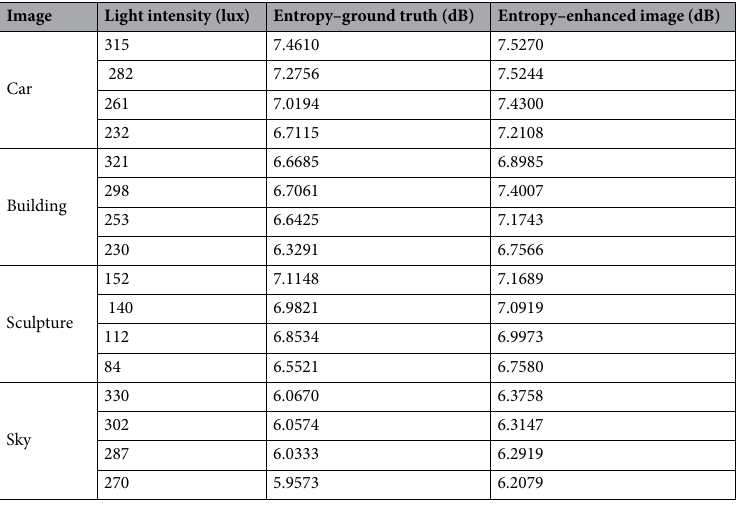
Table 4. Entropy of the